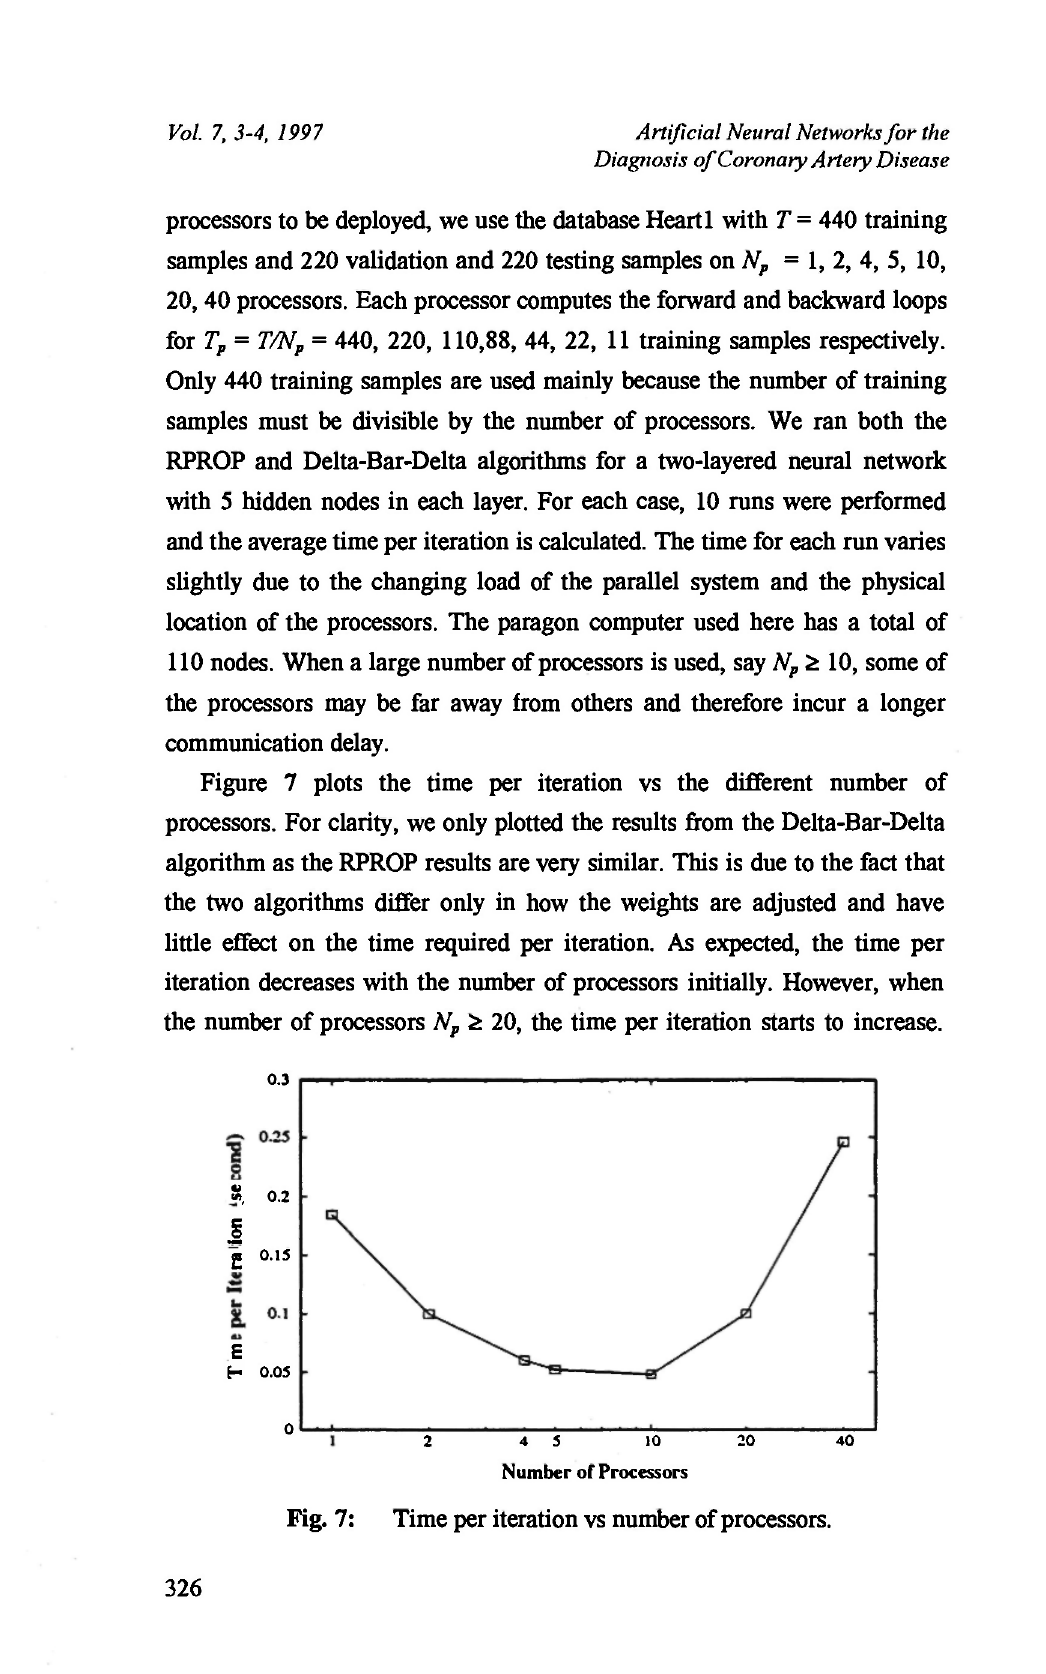
Fig. 7: Time per iteration vs number of